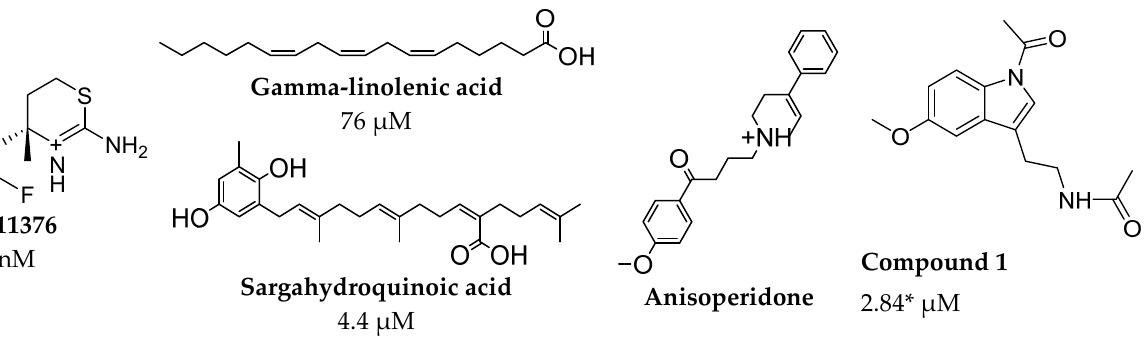
Figure 4. The selected potential allosteric inhibitors of BACE1 with reported IC 50 values (no data for anisoperidone and * indicates extrapolated from 88% inhibition of BACE1 at 5 µ M). Besides LY2811376 , all the molecules are naturally occurring compounds or their derivatives. LY2811376 0.9 nM [38,39]. Gamma-linolenic acid 76 µ M [31]. Sargahydroquinoic acid 4.4 µ M [40]. Anisoperi- done [41]. Compound 1 2.84* µ M [37].